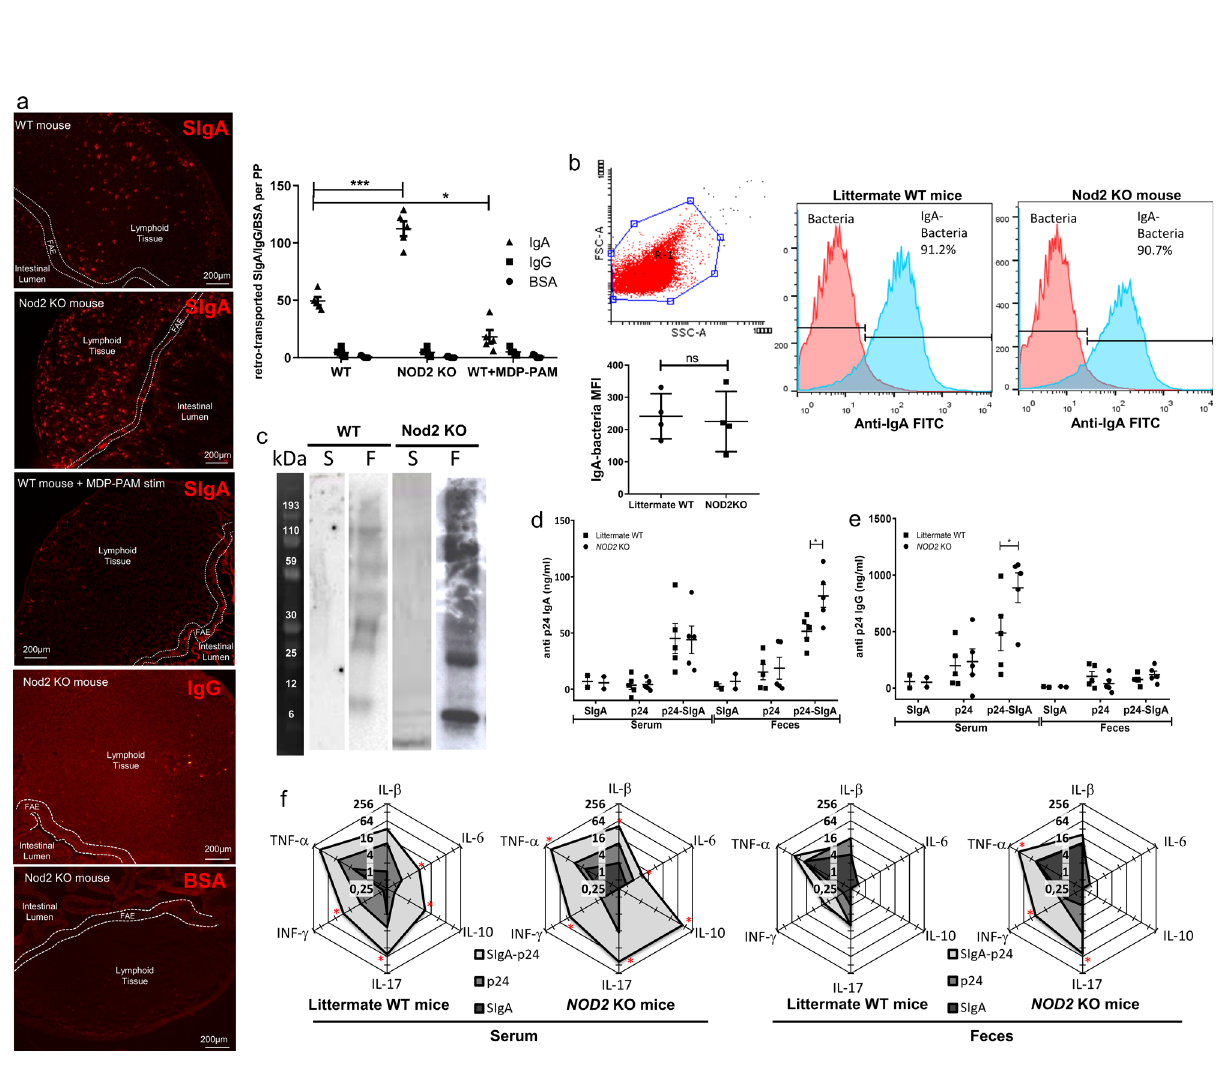
Fig. 2 NOD2 de fi ciency increases IgA retrograde transport in mice. a Tissue section showing a PP obtained from a ligated intestinal loop in WT, NOD2 KO or WT mice after MDP-PAM stimulation following exposure to SIgA-Cy3 for 60 min. Mouse IgG and the BSA were used as negative controls. The graph shows the number of SIgA-positive cells per PP. This experiment was repeated on 6 mice per group and an average of 3 PP per mouse was done. Vertical bars show the mean value±SEM. One-way ANOVA followed by Bonferroni post hoc test was used ( p values: * p < 0.05; *** p < 0.005). b Fecal bacteria from WT or Nod2KO mice were stained with anti-IgA-FITC and the MFI were calculated on IgA-bacteria. This experiment was repeated on 4 mice per group. Vertical bars show the mean value ± SEM. A nonparametric Mann – Whitney U -test was used (ns: not signi fi cant). c Lysed bacteria were used as the target antigens in a western blot, using serum (S) or fecal (F) supernatant from WT or NOD2 KO mice as primary antibody and anti – IgA-HRP as the secondary antibody. This experiment was repeated on eight cohoused mice (WT ( n = 4), NOD2 KO ( n = 4)) with similar results. NOD2 KO and littermate WT mice were cohoused and immunized orally with p24-SIgA. d Levels of Ag-speci fi c mucosal IgA and e levels of serum IgG in littermate WT or NOD2 KO mice were shown. Vertical bars show the mean value ± SEM. n = 5 biologically independent mice per group. One-way ANOVA followed by Bonferroni post hoc test was used ( p values: * p < 0.05; ** p < 0.01). f Cytokine concentrations in serum and faeces were determined in triplicate by Luminex-multiplex cytokine assay in littermate WT ( n = 3) and NOD 2 KO mice ( n = 3). Cytokine pro fi les are shown as radar charts; each axis displays the mean quantity (pg/ml) of each cytokine after immunization with p24-SIgA, p24 and PBS. A nonparametric Mann – Whitney U -test was used. P values have been calculated by comparing the p24-SIgA group with the p24 group; * p < 0.05. Source data are provided as a Source Data fi